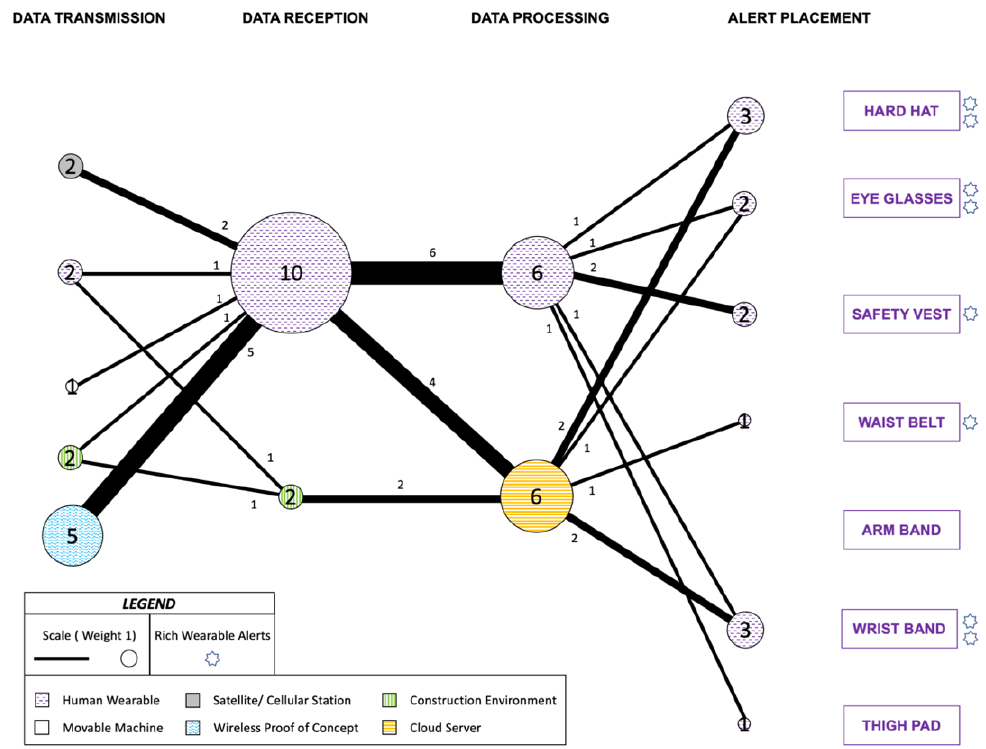
Figure 5. The Visual Communication Network for conveying textual or graphical information to construction worker-on-foot is displayed based on the insights from prior literature. Digits inside the nodes and next to the routes display the frequency of use.